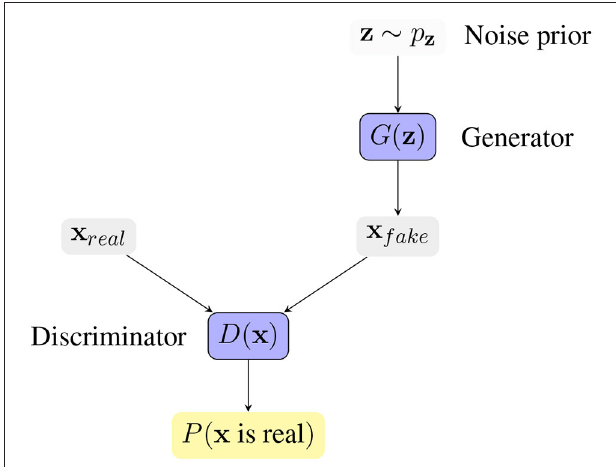
FIGURE 3 | Generative Adversarial Network framework. The generator G (z) receives a vector z sampled from a noise prior distribution p z , and generates a synthetic sample x f ake . The discriminator D (x) tries to distinguish real samples from fake samples, producing the probability of x coming from the real data distribution. The competition between the two players drives the game and makes both players increasingly better.